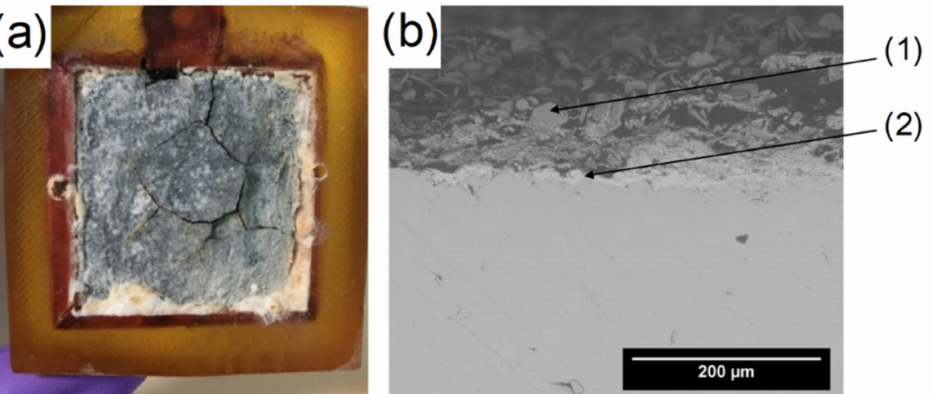
Figure 8. Photograph ( a ) and SEM cross-section view ( b ) of the Zn-1-coated electrode after the 6-month galvanic corrosion experiment. (1) and (2) = zones analyzed by EDS (see